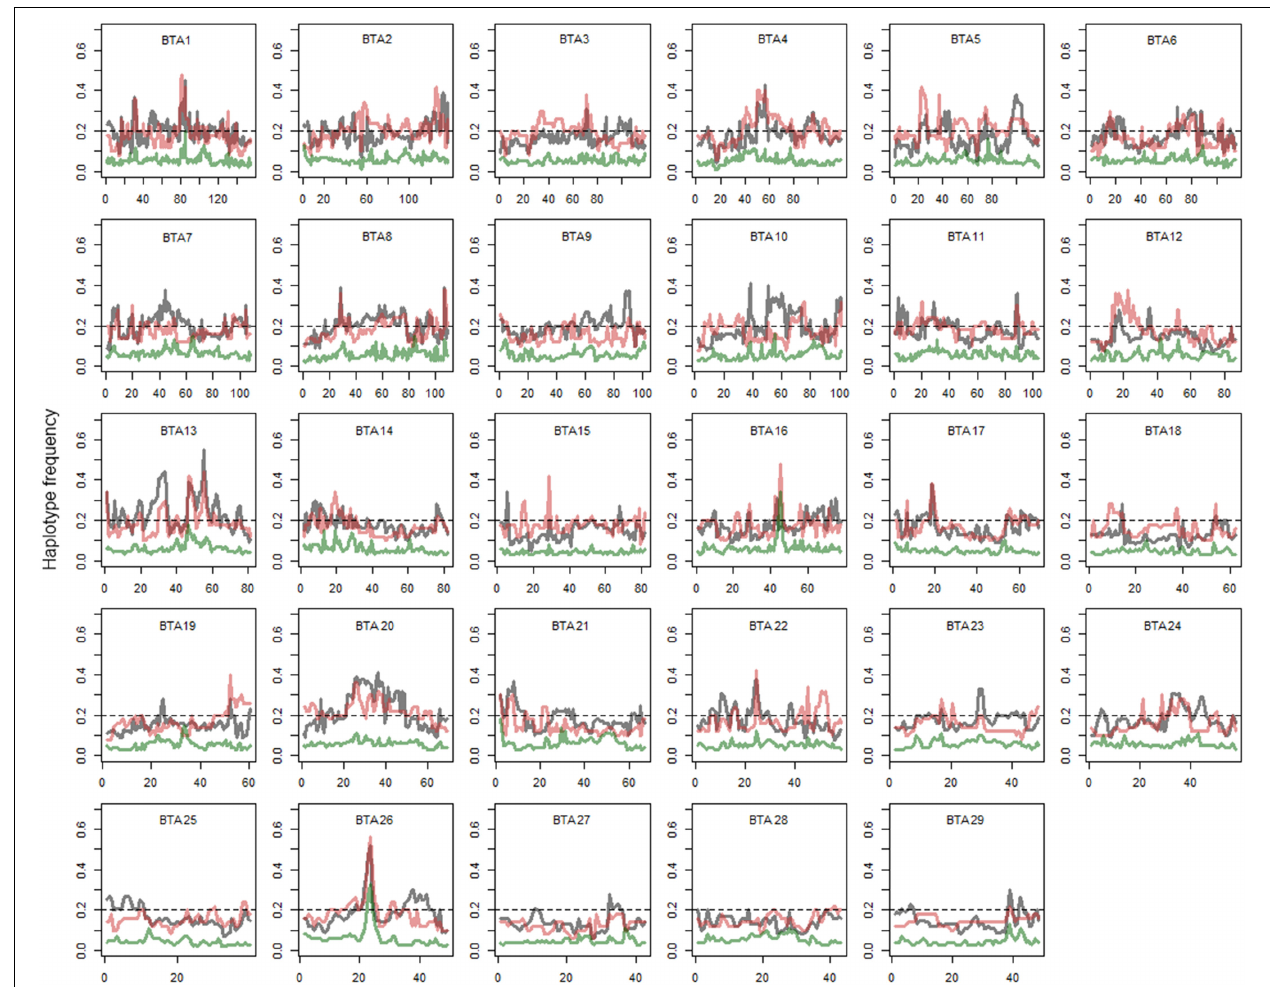
FIGURE 4 | The most frequent haplotypes in Holstein, Kenyan Friesian, and crossbreds. Gray, red, and green lines represent Holstein, Kenyan Friesian, and Kenyan crossbreds, respectively. Gray line, Holstein; Red line,